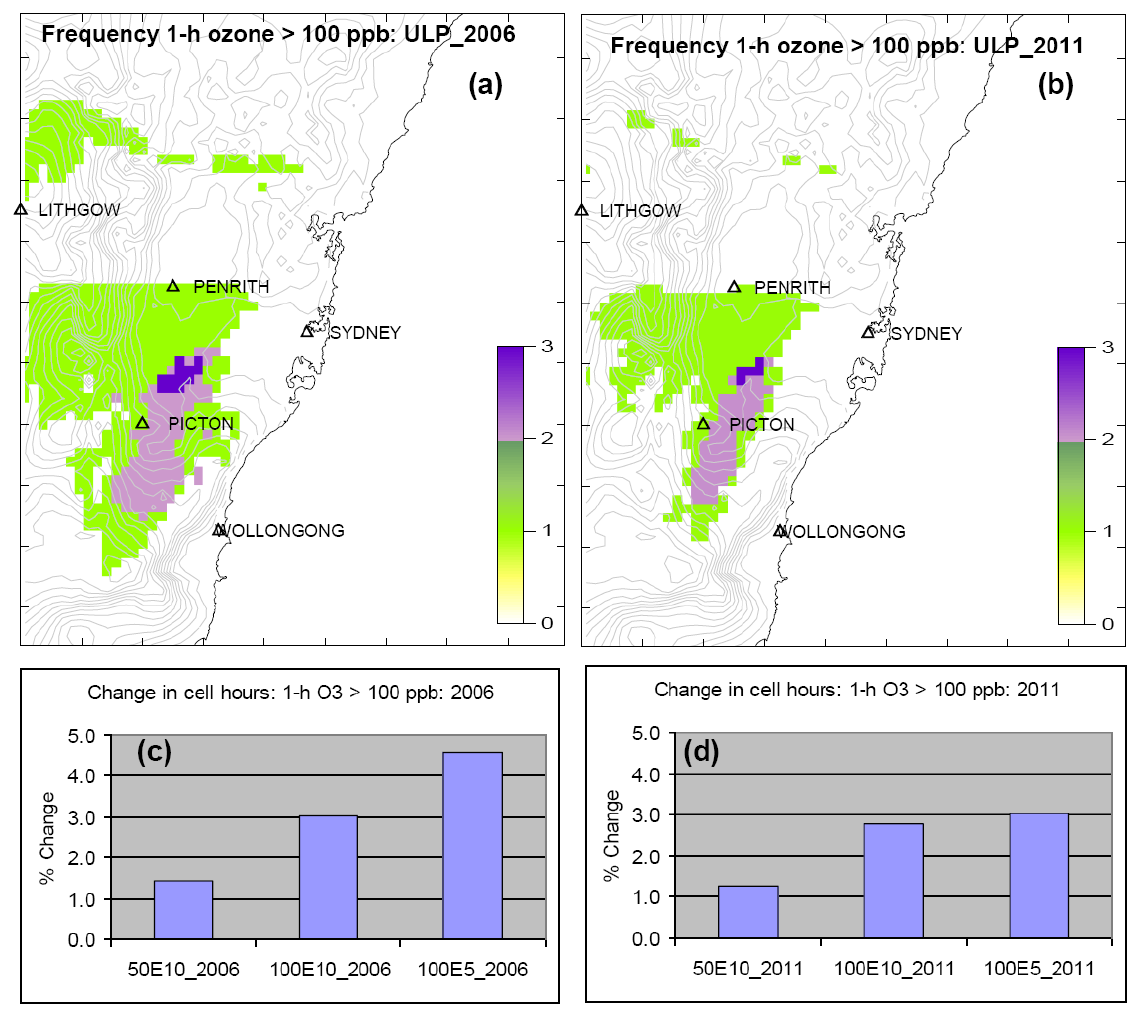
Figure 2. Impacts of the modelled ethanol scenarios on 1-hour ozone statistics for Sydney ( a ) Daily number of exceedences for 1-hour ozone concentration >100 ppb for the one month simulation using the ULP_2006 motor vehicle inventory; ( b ) As for ( a ) but using the ULP_2011 inventory; ( c ) Percentage relative change in the number of exceedence cell-days when using the 2006 ethanol inventories; ( d ) As for ( c ) but using the 2011